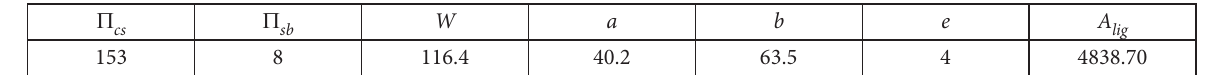
Fig. 28. Finite element (FE) Fig. 26. Characteristic specimen’s dimension Table 4. Dimention of the specimen in mm